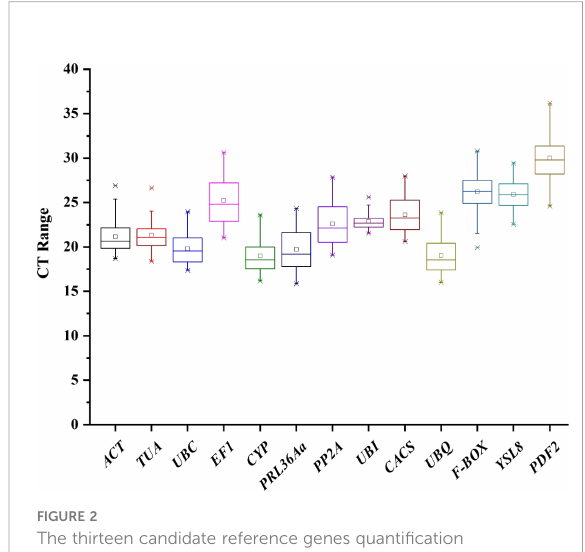
FIGURE 2 The thirteen candidate reference genes quanti fi cation cycle